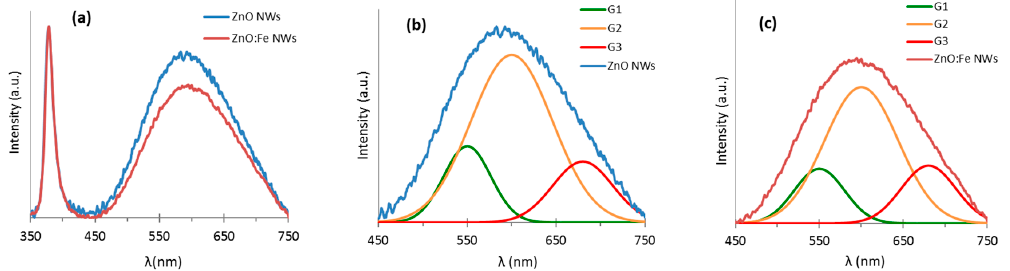
Figure 8. ( a ) Photoluminescence spectroscopy (PL) spectra of undoped ZnO NWs (blue curve) and Fe-doped ZnO NWs (red curve); ( b , c ) Visible emission band of PL spectrum and three Gaussian components G1 (green), G2 (yellow) and G3 (red) for ZnO NWs and ZnO:Fe NWs, respectively.